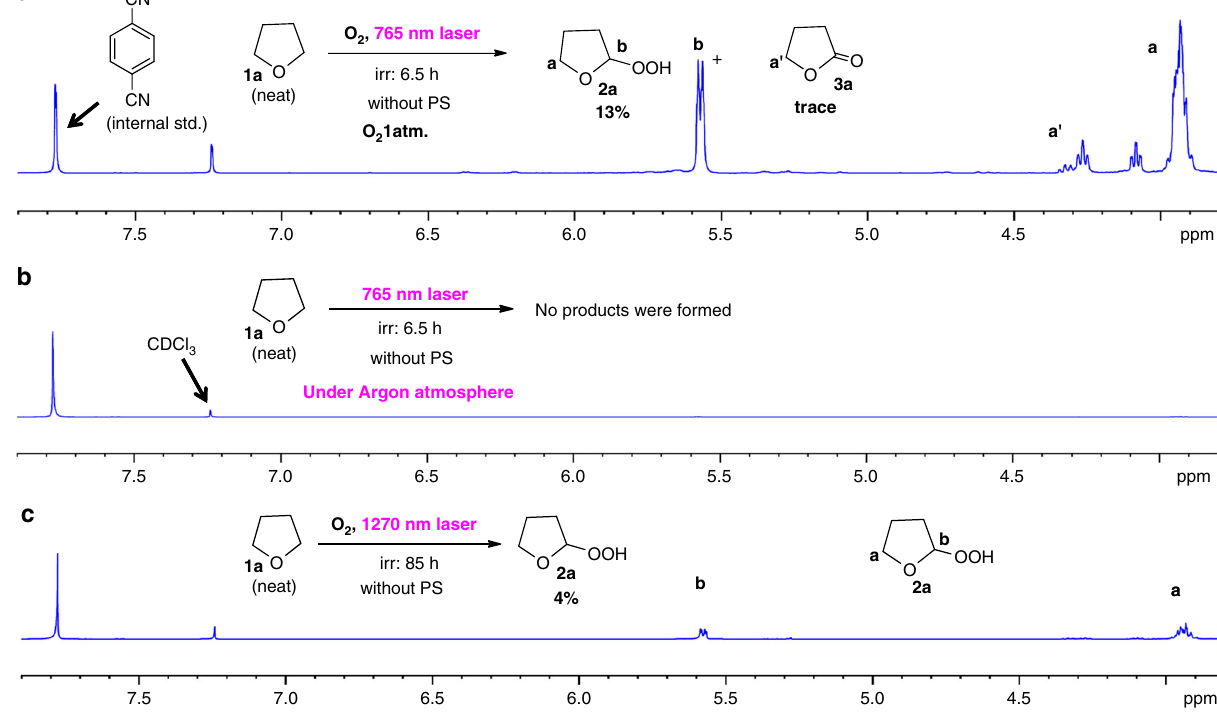
Fig. 1 1 H-NMR spectra of photo irradiation products. Products were obtained from direct photoexcitation of molecular oxygen in a neat THF solution under different conditions: a O 2 atmosphere, 765 nm, 477 mW cm − 2 , continuous wave (CW mode), 6.5 h; b Ar atmosphere, 765 nm, 477 mW cm − 2 , CW mode, 6.5 h; and c O 2 atmosphere, 1270 nm, 3.2 mWcm − 2 , CW mode, 85 h. PS =